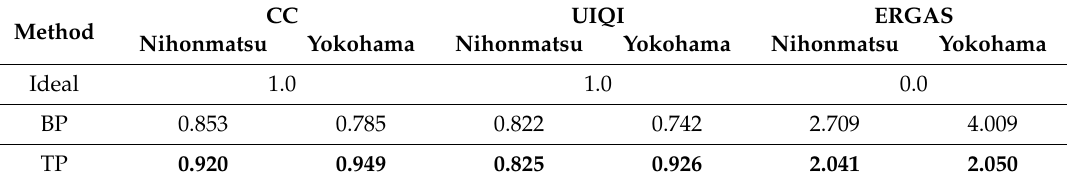
Table 6. Comparison of the back-projection and the tradeo ff process. The best values are given in bold.